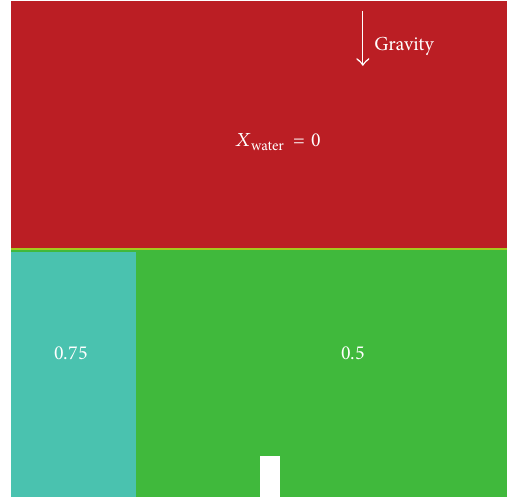
Figure 2: Initial condition of collapsing liquid-liquid dispersion test case.